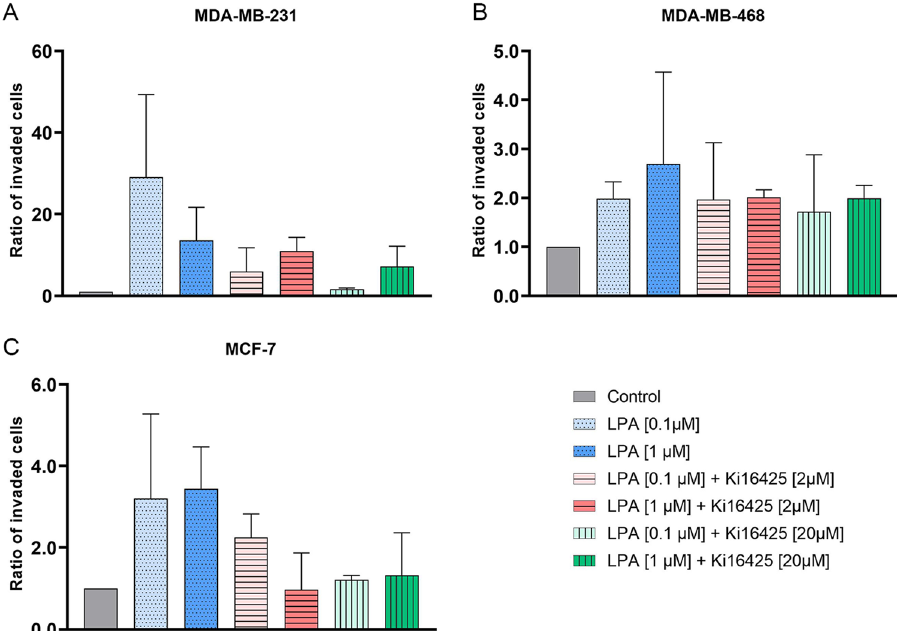
Figure 3. Invasion assay. Effect of lysophosphatidic acid (LPA) 18:1 and the LPA receptor 1, 3 (and 2) inhibitor Ki16425 on invasion of different human breast cancer cell lines (control = 1). (A–C) Columns show the ratio of invaded cells compared to the control group (y-axis) in varying concentrations of LPA and Ki16425 (x-axis). n = 2 replicate experiments, values are presented as mean ± SD. For LPA 0.1 μM and LPA 1.0 μM stimulation was compared to the control group; for LPA 0.1 μM/LPA 1.0 μM + Ki16425 2/20 μM inhibition was compared to the respective LPA group without Ki16425.